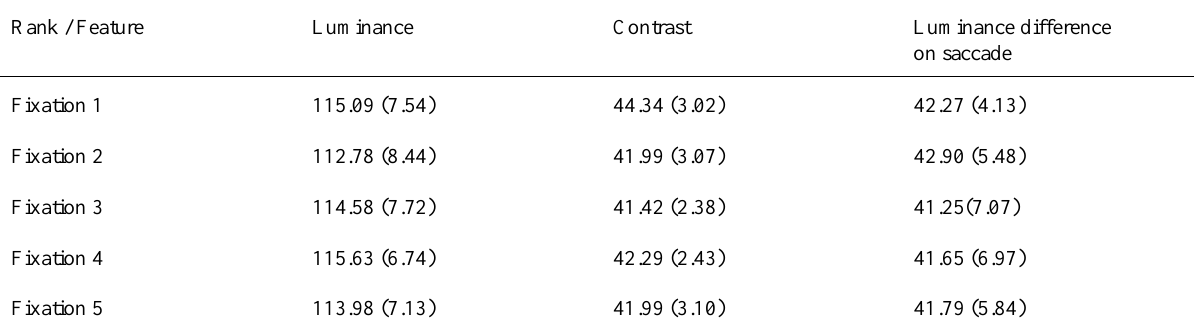
Table 3 Statistical summary for the first five fixations, of the image features of the fixated region: mean local luminance, local contrast computed by the standard deviation of the local luminance and absolute value of the difference of the mean luminance of fixated regions before and after the incoming saccade, based on individual means (std), at the start of free